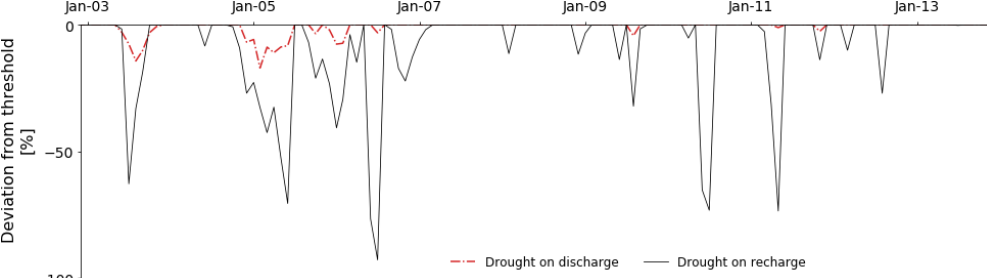
Figure 14. Comparison of drought events on groundwater recharge and groundwater discharge using the percent deviation from the